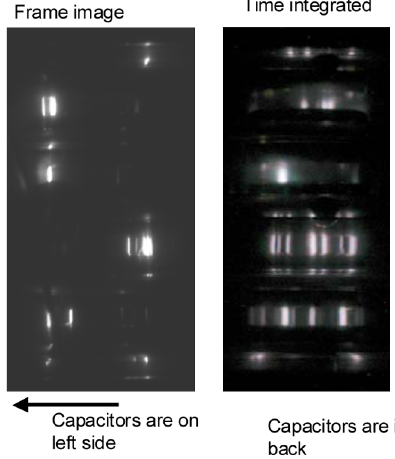
FIG. 24. Images of the Russian switch breakdown taken 90 de- grees apart from each other. The left image is a 10 ns frame picture and the right image is a time-integrated picture. While there are multiple arcs in most gaps, the arcs tend to cluster in small areas of the electrodes, which limits the impact of the multiple arcs on the switch inductance.